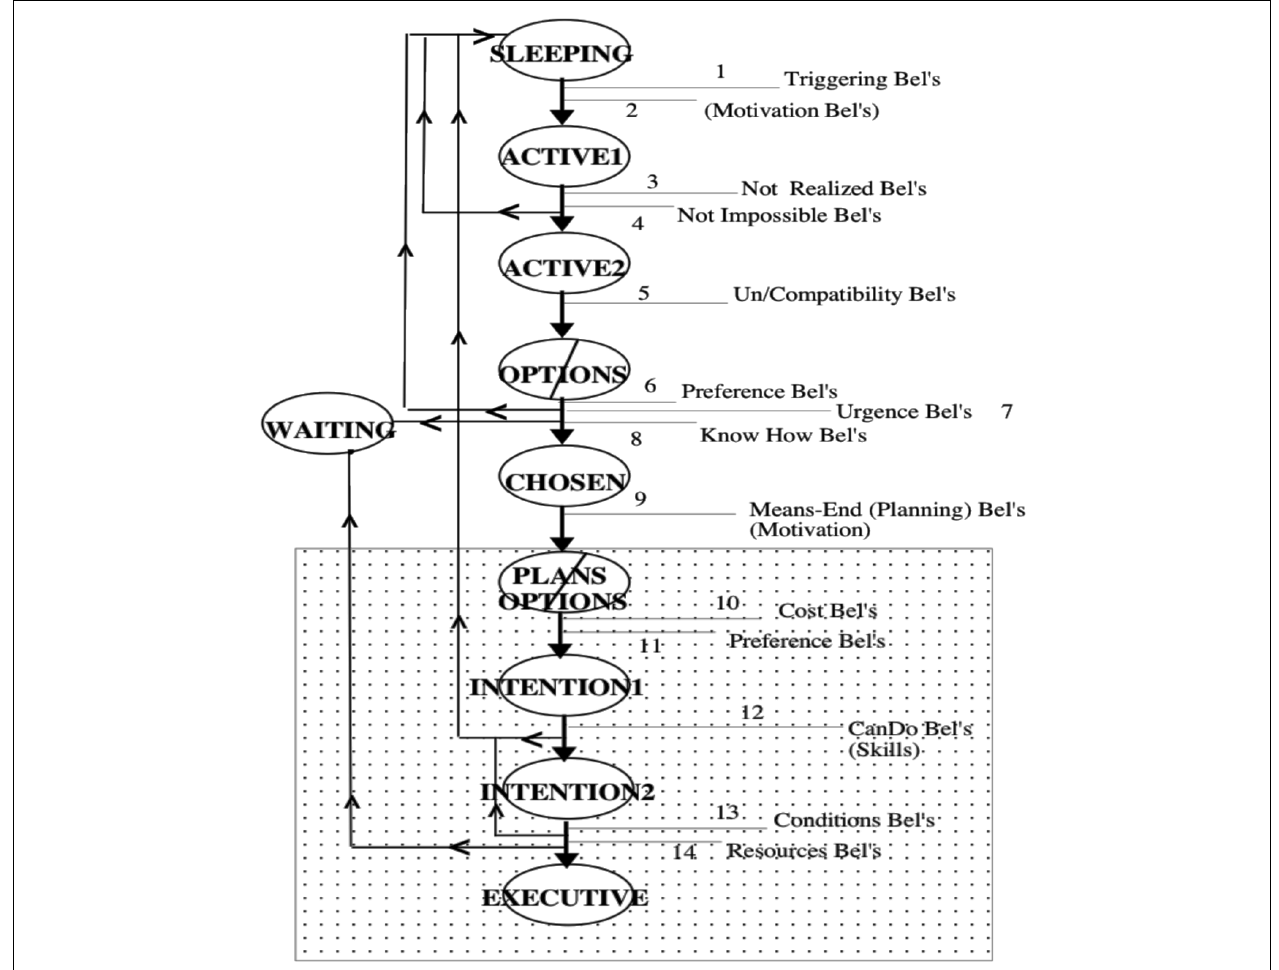
FIGURE 1 | Beliefs in Goal-Processing (Castelfranchi and Paglieri,